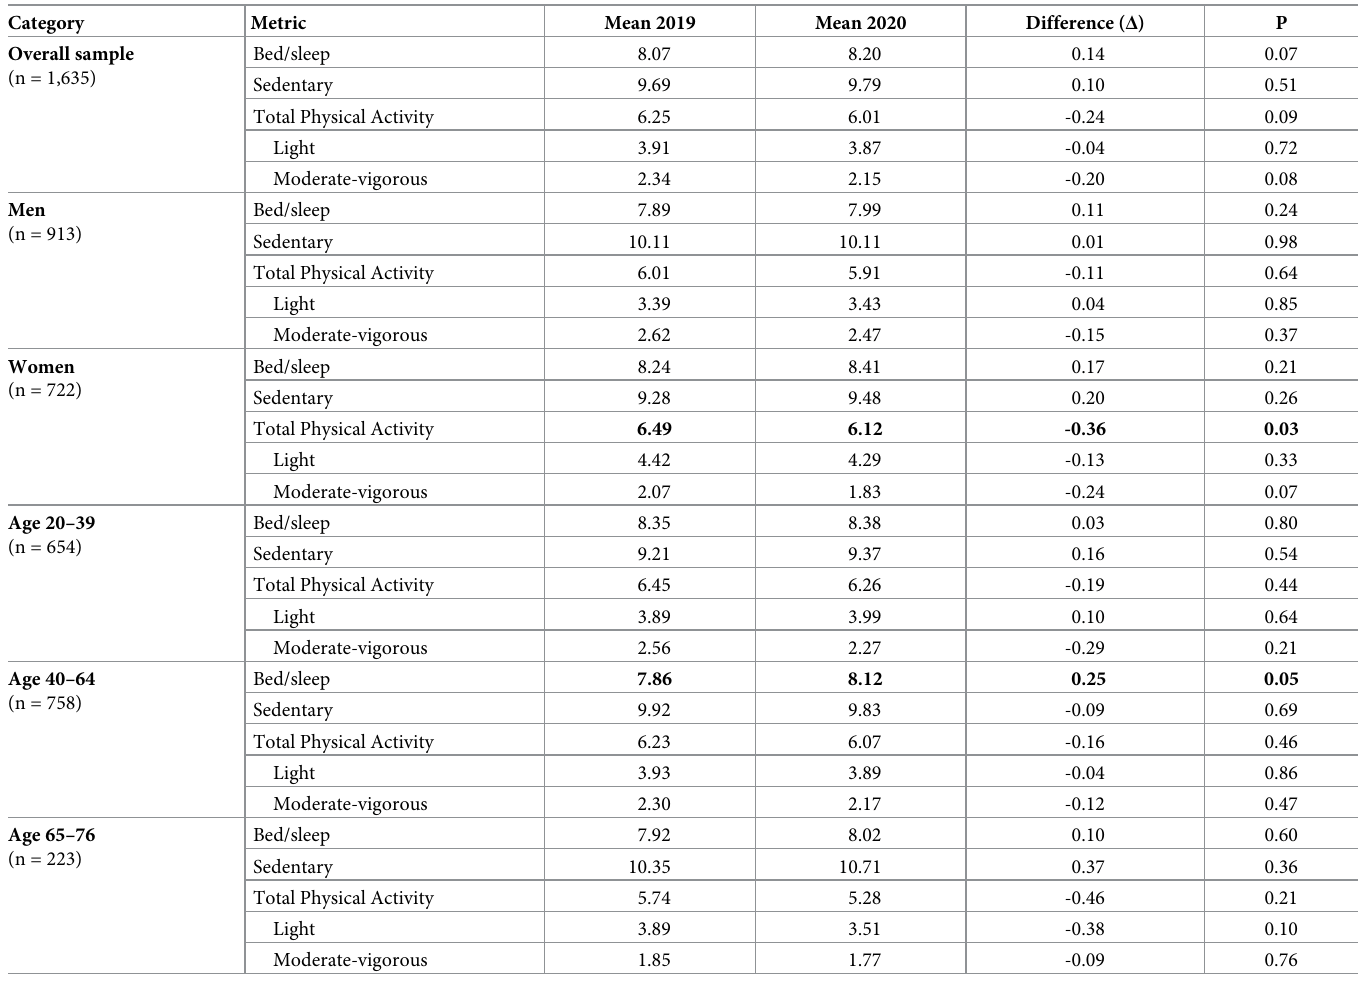
Table 2. Difference in time spent (hours/day) in daily behaviors pre-pandemic in Fall 2019 and Fall 2020, by sex and age-group—US adults.